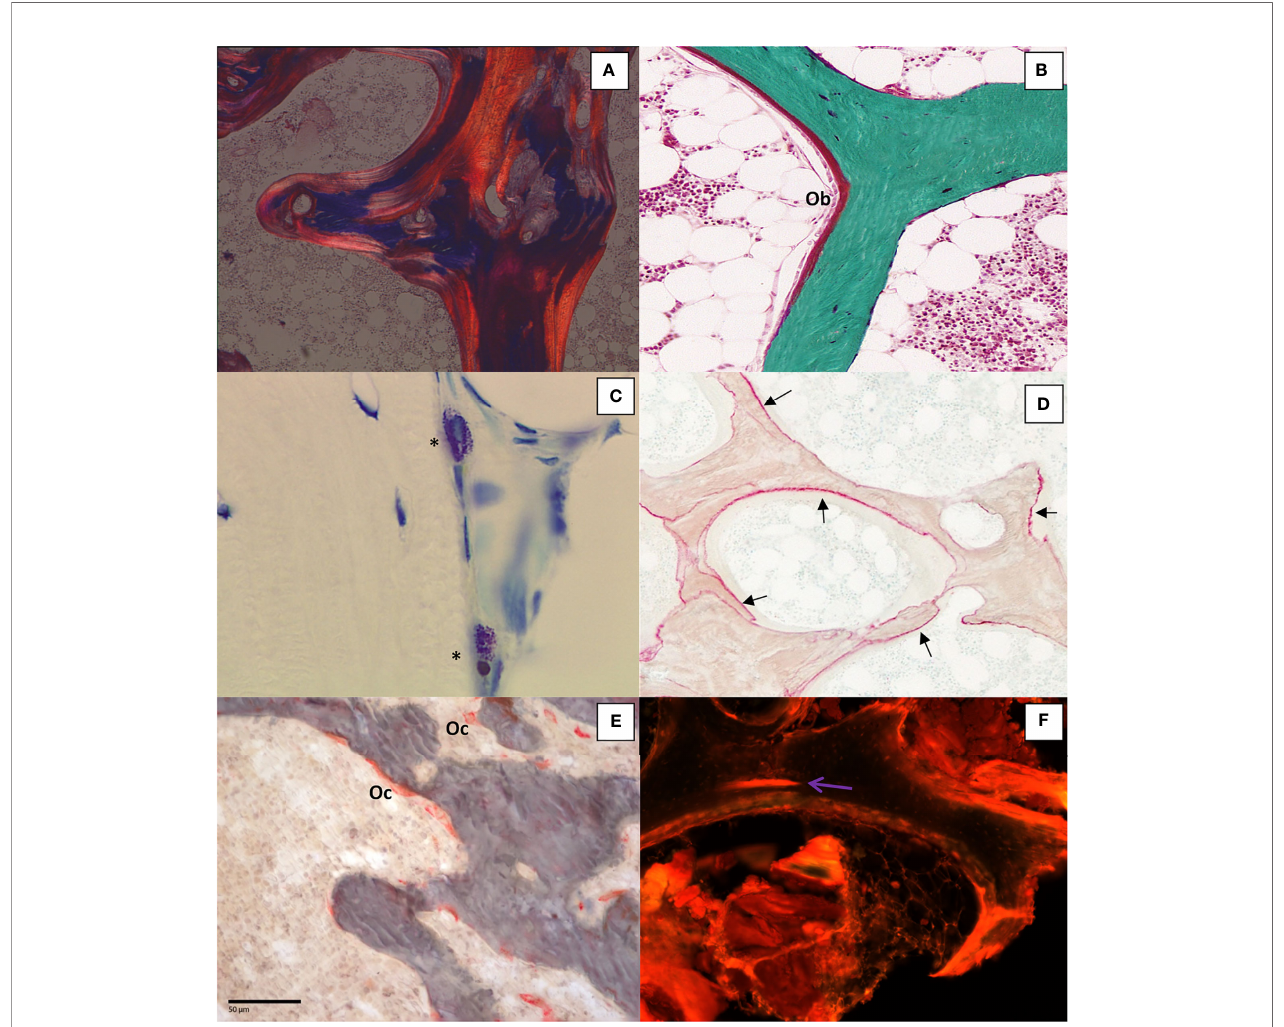
FIGURE 2 | (A) Bone section stained with solochrome cyanin R under polarized light showing the lamellar texture of bone tissue (x100); (B) Goldner trichrome differentiates mineralized bone in green and osteoid seam covered by osteoblasts (Ob) in red (x200); (C) Mast cells (*) in bone marrow characterized by the presence of metachromatic granules in the cytoplasm after toluidin blue pH 2.6 staining (x400); (D) Aluminon staining showing the aluminum deposition ( ! ) along the calci fi cation front (x100); (E) .TRAP staining of osteoclasts (Oc) (x200); (F) : Microcrack ( ! ) stained after bulk staining with xylenol orange